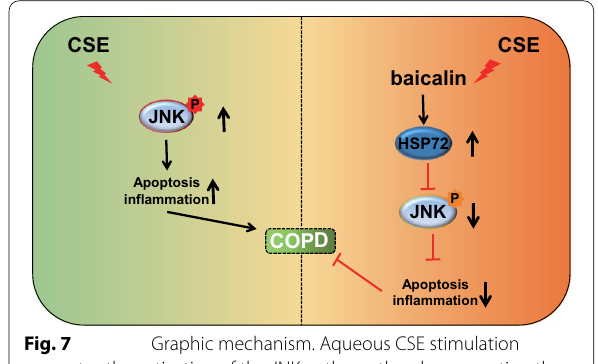
Graphic mechanism. Aqueous CSE stimulation promotes the activation of the JNK pathway thereby promoting the development of COPD, while baicalin can up-regulate the expression of HSP72, which in turn inhibits the activity of the JNK pathway and impedes the development of